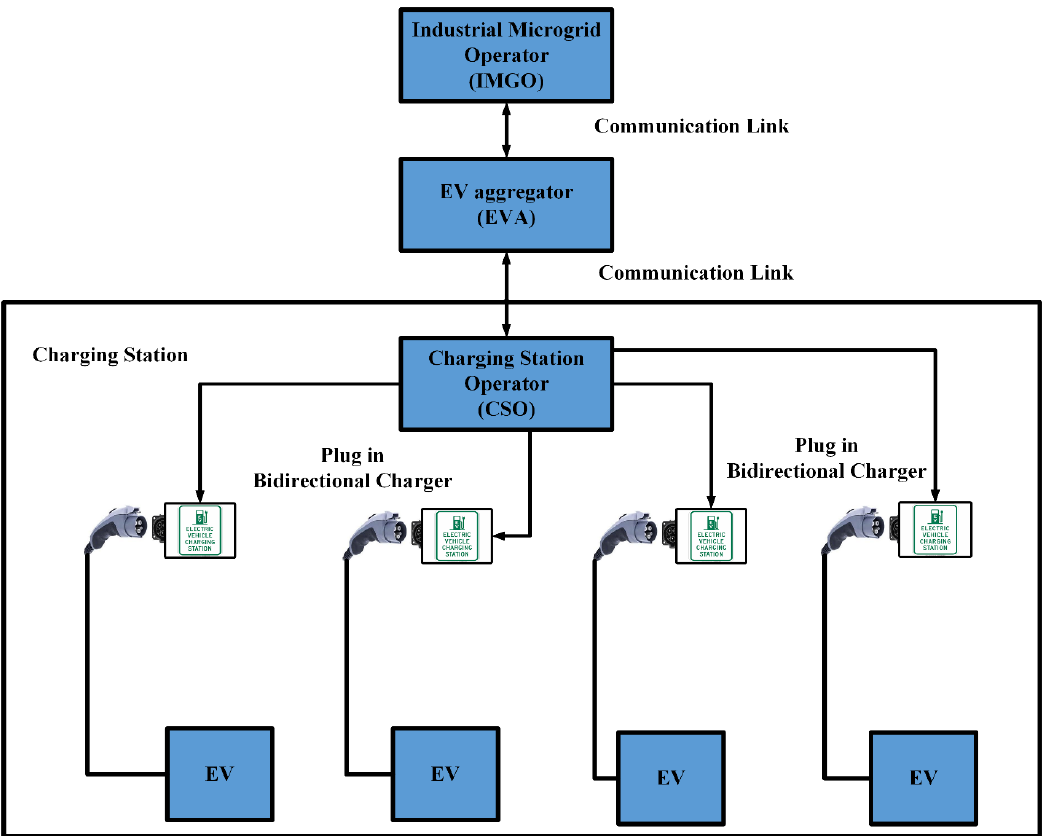
Table 1. Nominal values of voltage and frequency.